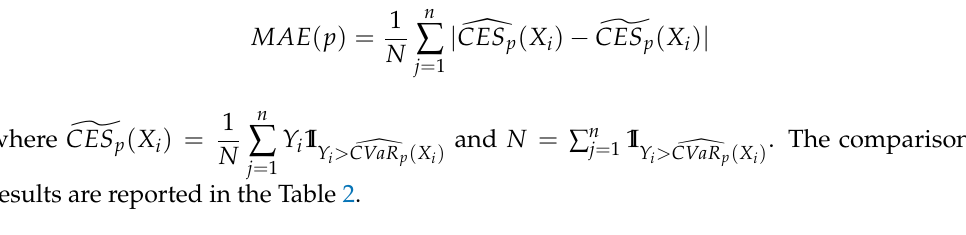
Table 2. Comparison of the MAE- error between Nonparametric functional model and semiparametric multivariate